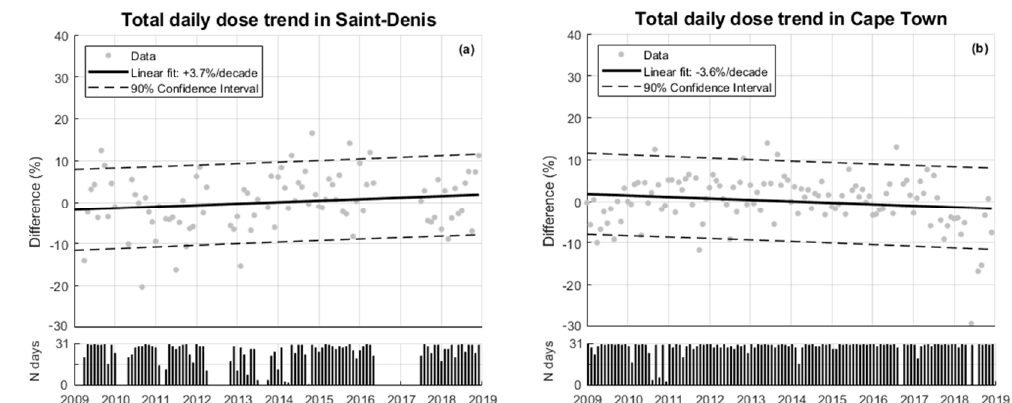
Figure 6. Total daily erythemal dose trend estimates in Saint-Denis ( a ) and Cape Town ( b ). The grey dots represent the relative difference from the monthly mean of daily doses to the climatological monthly mean of daily doses. The histogram shows the numbers of days with data available in each month. The black solid line represents a linear fit and the black dashed lines the 90% confidence interval.